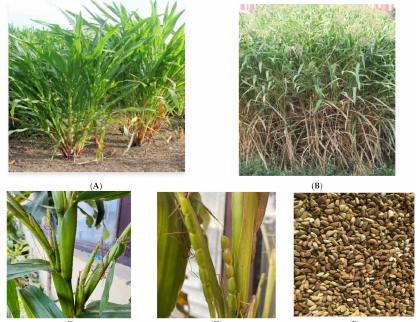
Figure 1. ( A ) Teosinte at the vegetative stage. ( B ) Teosinte at the flowering stage. ( C ) Teosinte cobs. ( D ) Teosinte ears. ( E ) Teosinte